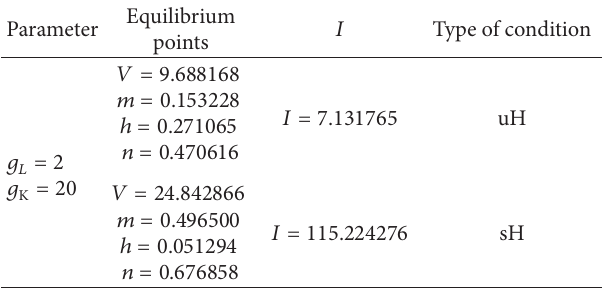
Table 4: Bifurcation analysis results derived by the Matcont soft-